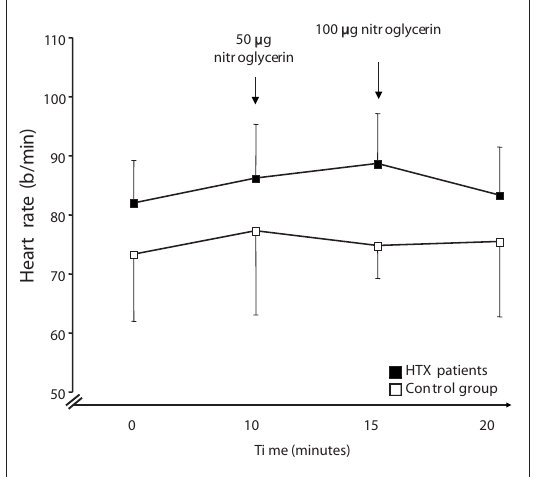
Changes in heart rate induced by nitroglycerin in heart- transplanted patients and in the control hypertensive group. Heart rate recorded in heart-transplanted (HTx) patients and in the hypertensive control group at baseline, after administration of 50 mg and 100 mg nitroglycerin and during the recovery time (8 ± 3 minutes after the last infusion of nitroglycerin). Data are expressed as mean ±